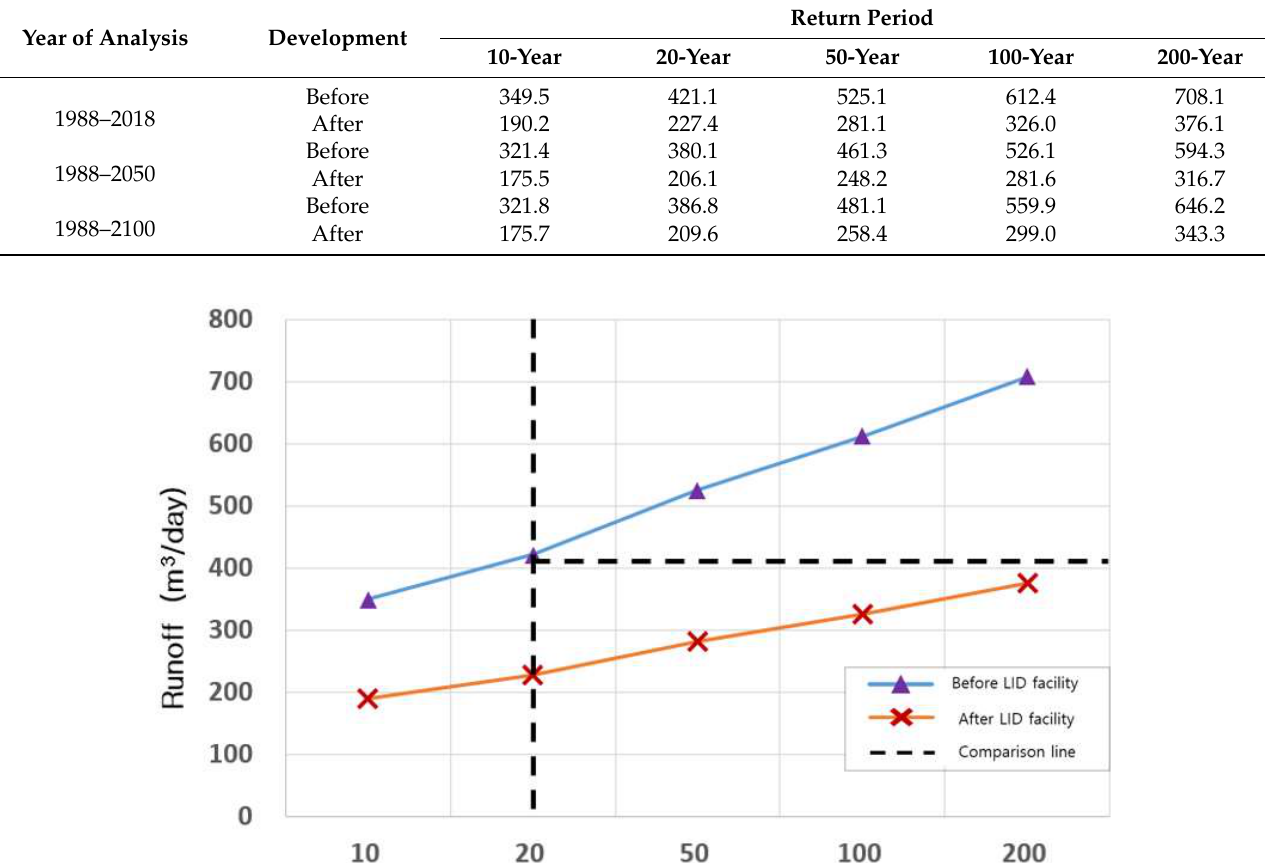
Table 12. Runoff by return period using RCP 4.5 scenario (unit: m 3 /day).